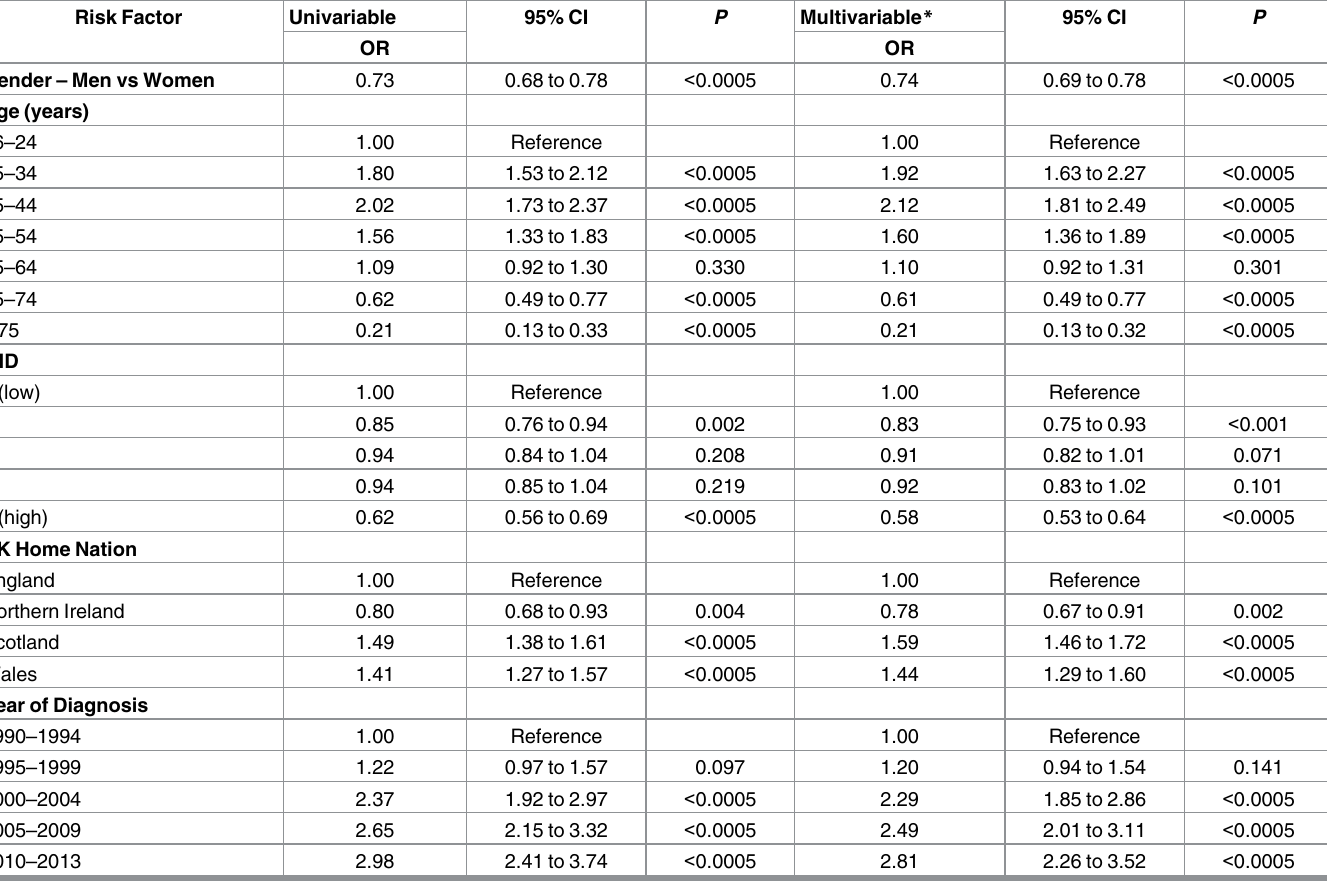
Table 3. Univariable and Multivariable odds ratios analysis for the association between individual patient factors associated with prescribing drugs for alcohol dependence. Risk